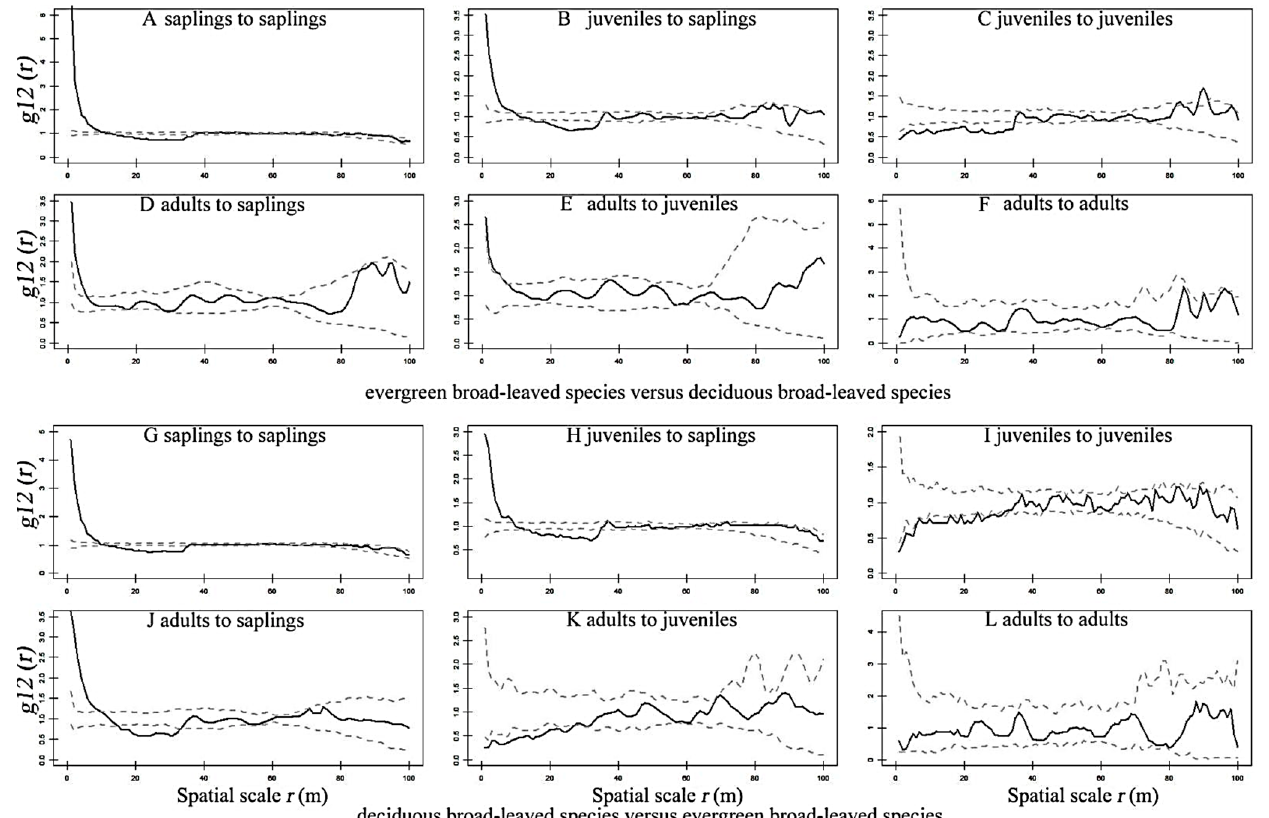
Figure 6. Spatial associations of evergreen broad-leaved species versus deciduous broad-leaved species among different DBH classes. The 99% confidence interval is indicated by dotted lines and the g12(r) function is in black. Observed values below the lower limits represent a negative association, values above the upper limits mean positive association, and values within the intervals mean there is no association. ( A , G ) saplings to samplings; ( B , H ) juveniles to saplings; ( C , I ) juveniles to juveniles; ( D , J ) adults to saplings; ( F , L ) adults to adults.